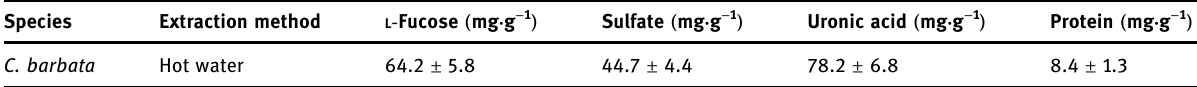
Table 1: Chemical pro fi le of C. barbata extract used for Fu production Species